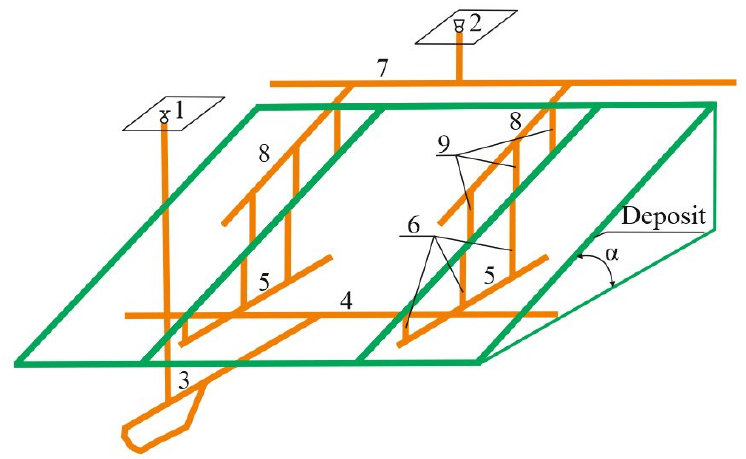
Figure 2. Rock access structure: 1—output shaft; 2—ventilation shaft; 3—transportation crosscut; 4—directional rock drift; 5—field rock drift; 6—output (mining) small shafts; 7—ventilation direc- tional rock drift; 8—ventilation inclined drift; 9—ventilation small shafts.